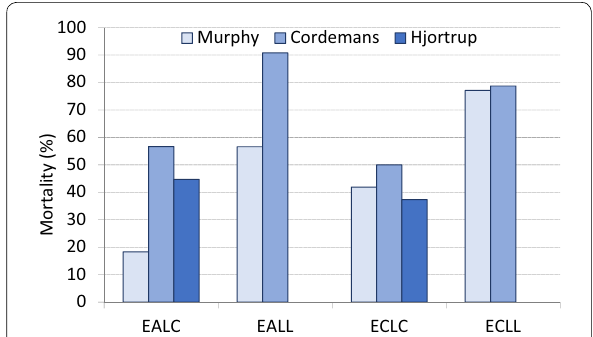
Fig. 4 Impact on outcome of appropriate timing of fluid administra‑ tion. Bar graph showing outcome (mortality %) in different fluid man‑ agement categories. Comparison of the data obtained from different studies: hospital mortality in 212 patients with septic shock and acute lung injury, adapted from Murphy et al. (light blue bars) [38], hospital mortality in 180 patients with sepsis, capillary leak and fluid overload, adapted and combined from two papers by Cordemans et al. (middle blue bars) [40, 41], 90‑day mortality in 151 adult patients with septic shock randomized to restrictive versus standard fluid therapy (CLAS‑ SIC trial), adapted from Hjortrup et al. (dark blue bars) [39]. See text for explanation. EA: early adequate fluid management, defined as fluid intake > 50 mL/kg/first 12–24 h of ICU stay. EC: early conservative fluid management, defined as fluid intake < 25 mL/kg/first 12–24 h of ICU stay. LC: late conservative fluid management, defined as 2